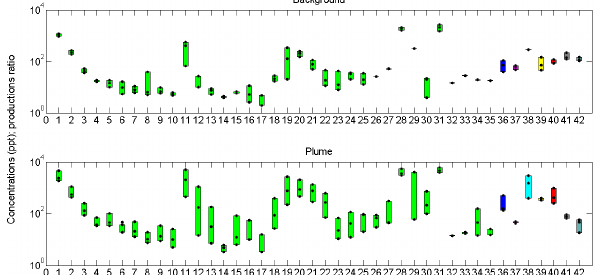
Figure 8. Average concentrations of the species involved in the O 3 and P PN production. VOCs are in green, CO in red, NO 2 in blue, O 3 in magenta, P PNs in cyan, and P ANs in yellow. In grey is re- ported the ratio between the P( O 3 ) and P( P PNs ) evaluated using the direct calculation (see Sect. 3.3); in teal blue is reported the ratio between the P( O 3 ) and P( P PNs ) evaluated using the model sim- ulation. The upper panel shows data measured during background flights (B619, part of B622, B630); the lower panel shows data from fire plume flights (part of B622, B623, B624). The parame- ters shown in this figure are numbered according to Table